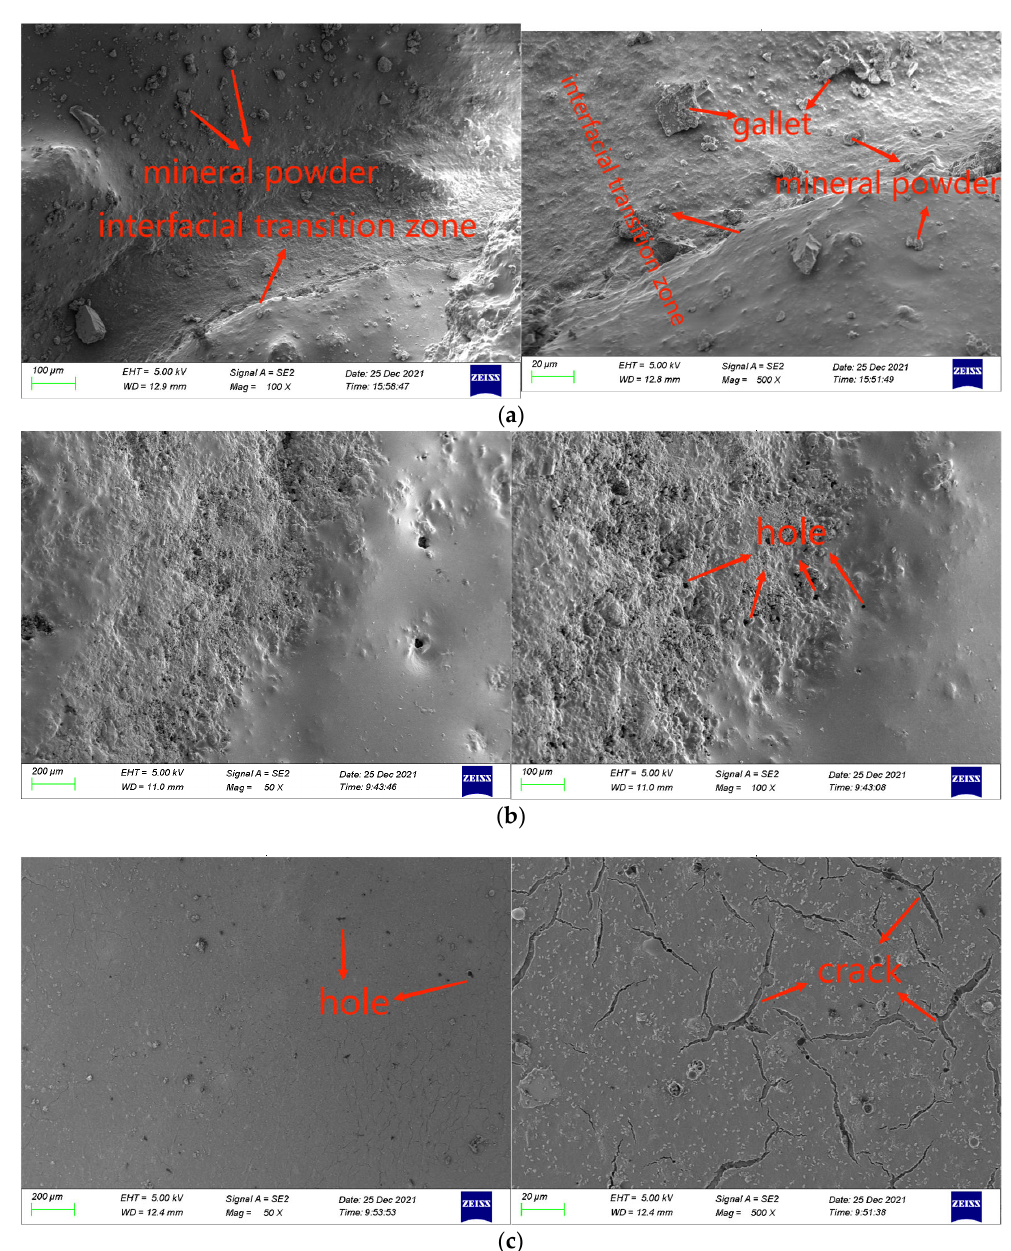
Figure 10. Microscopic morphology of PCRM mixture with 60% RAP dosage. ( a ) Ampli fi ed factor 100. ( b ) Ampli fi ed factor 500.